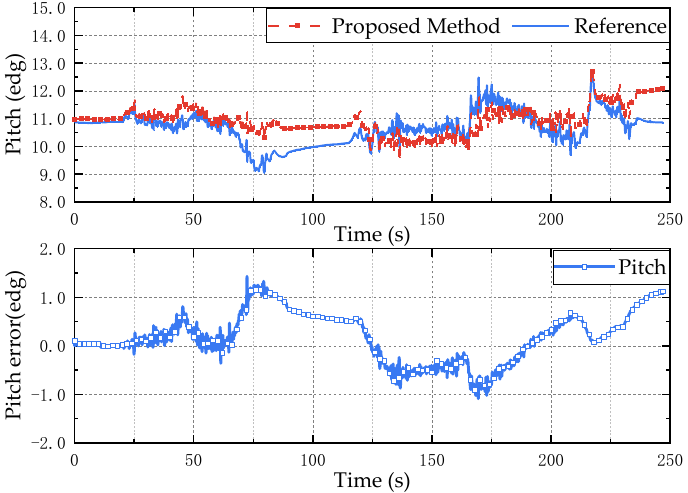
Figure 15. Pitch angle anti-interference test results. The above is the estimation result of the proposed method, and the bottom is the error between the estimated value and the reference value.